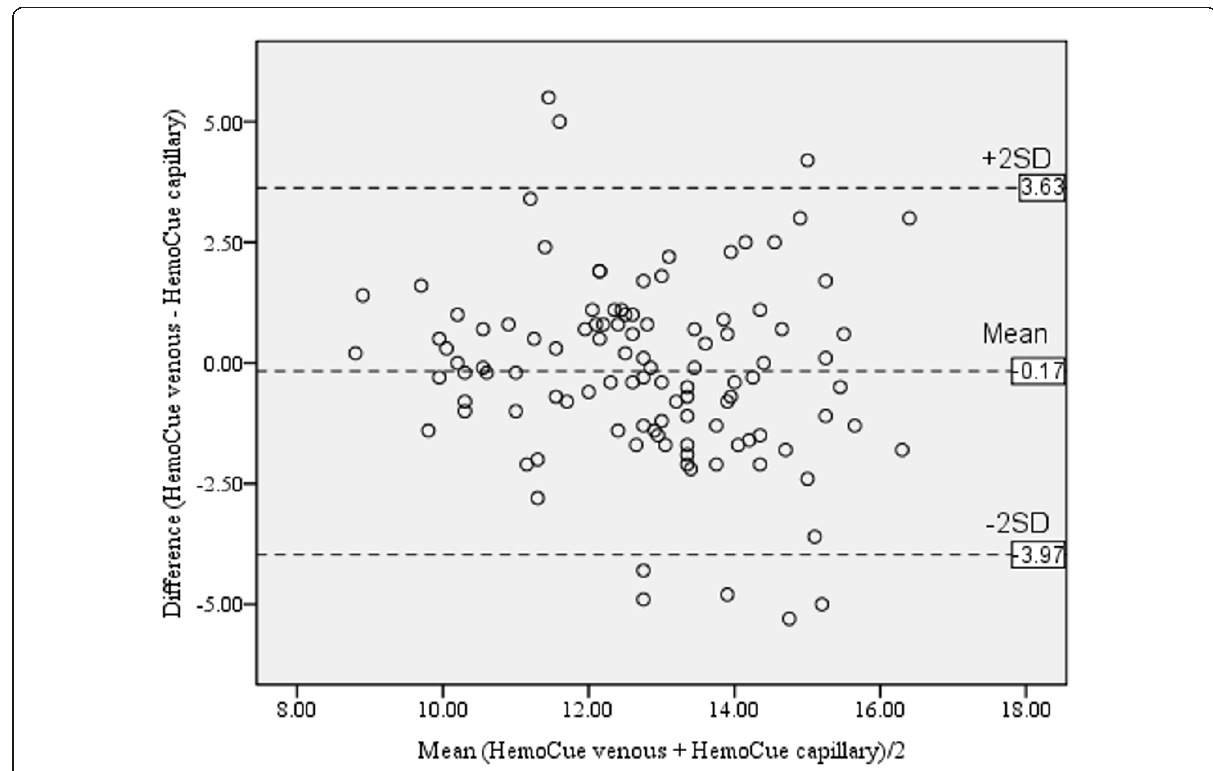
Figure 3 Bland and Altman plot for hemoglobin level by using HemoCue ® venous sample versus HemoCue ® capillary sample (g/dl)